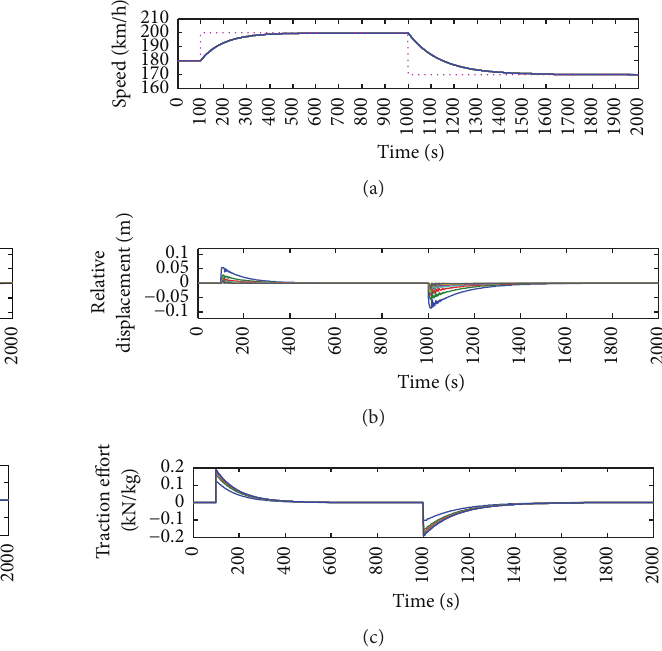
Figure 6: Optimal curves for each car under the fuzzy constrained predictive controller with actuator